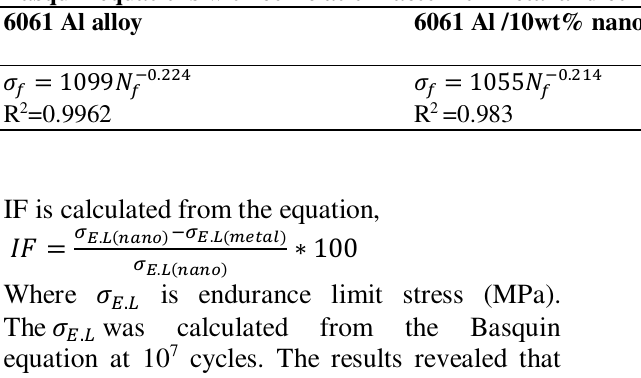
endurance limit